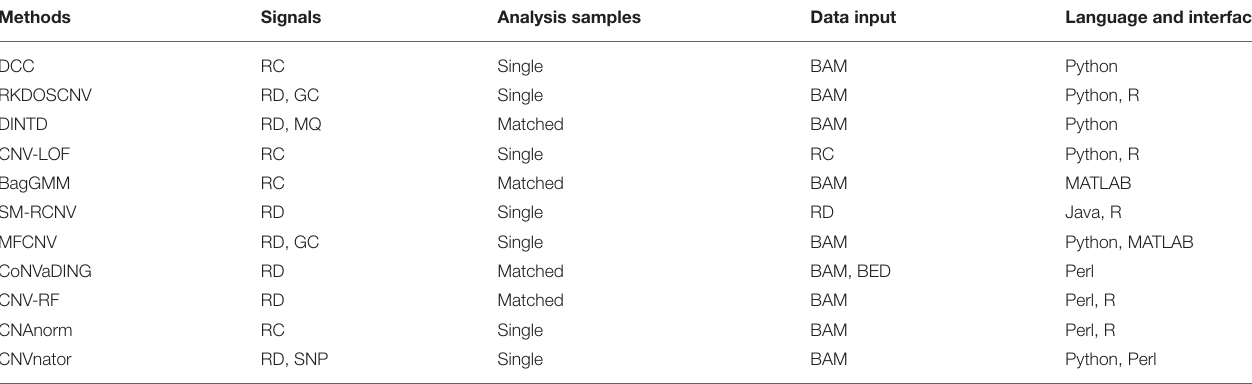
TABLE 1 | Comparison of existing